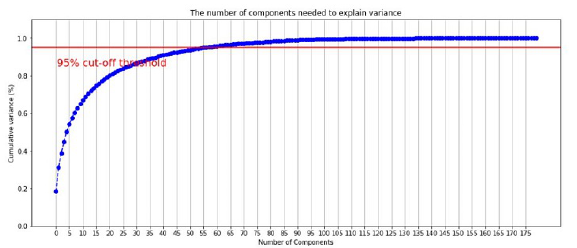
Figure 4. Plot indicating the number of components needed to illustrate variance